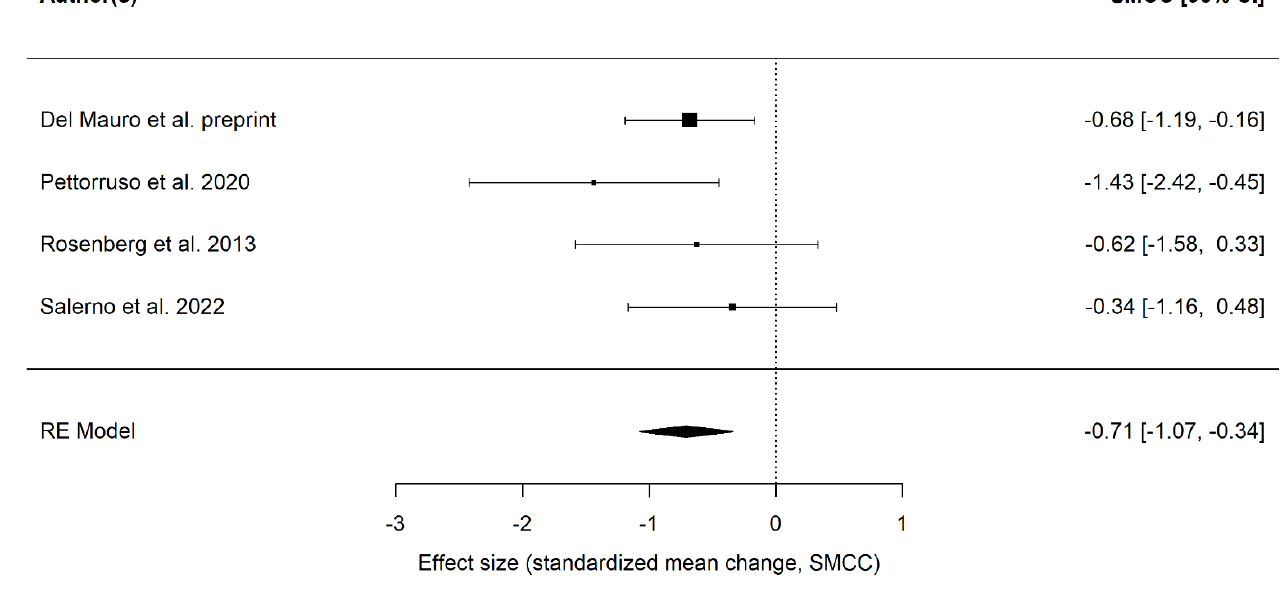
Figure 4. Forest plot of the effect size of NiBS on depressive symptoms. Del Mauro et al. preprint [98], Pettorruso et al. [104], Rosenberg et al. [105], Salerno et al. [106].